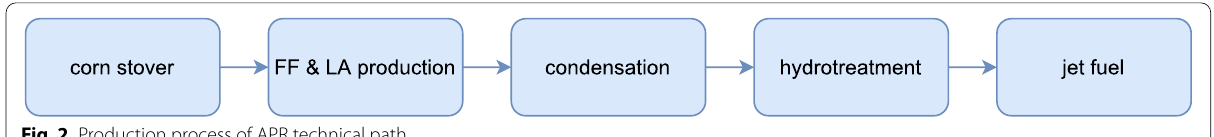
Fig. 2 Production process of APR technical